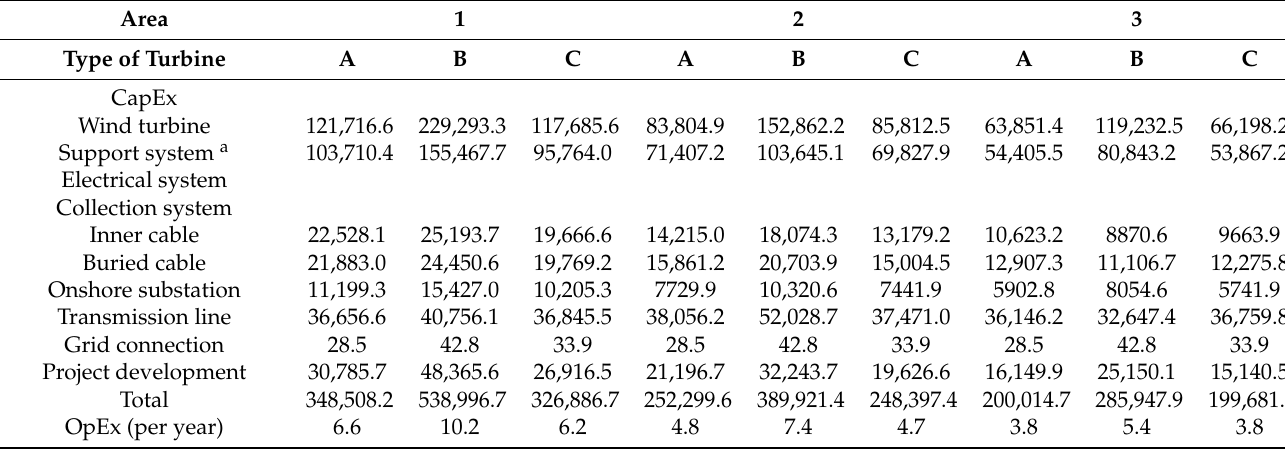
Table 6. Cost breakdown of wind farms off Wetar Island by area and turbine (all costs in thousands of USD). Area